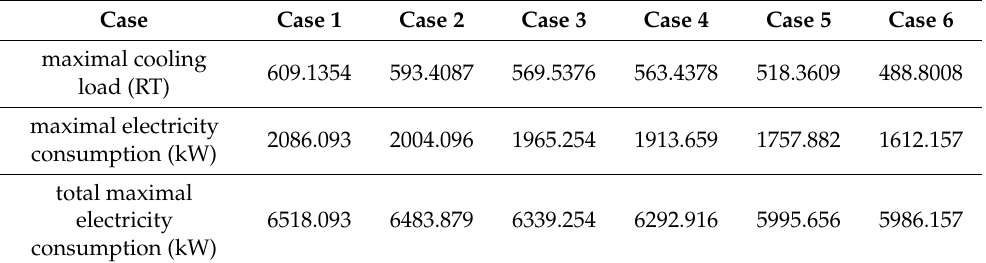
Table 6. The power consumption of the different cases in a single